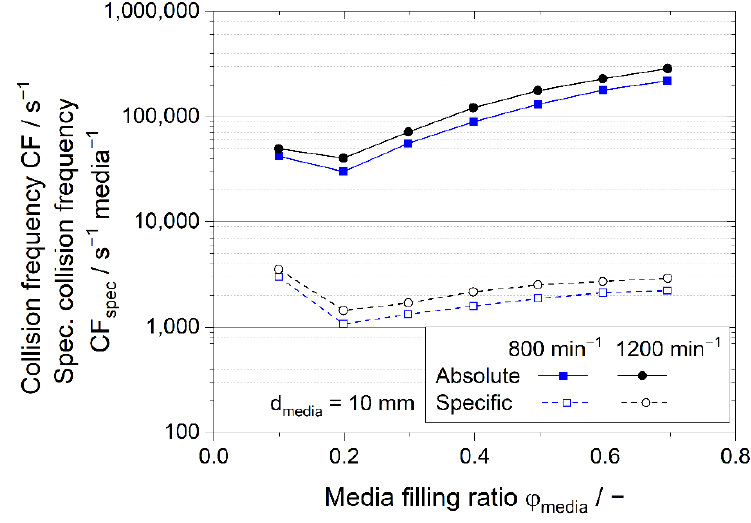
Figure 7. Collision frequency in dependence on media filling ratio, shown as absolute and normalized (per media) values; d media = 10 mm.